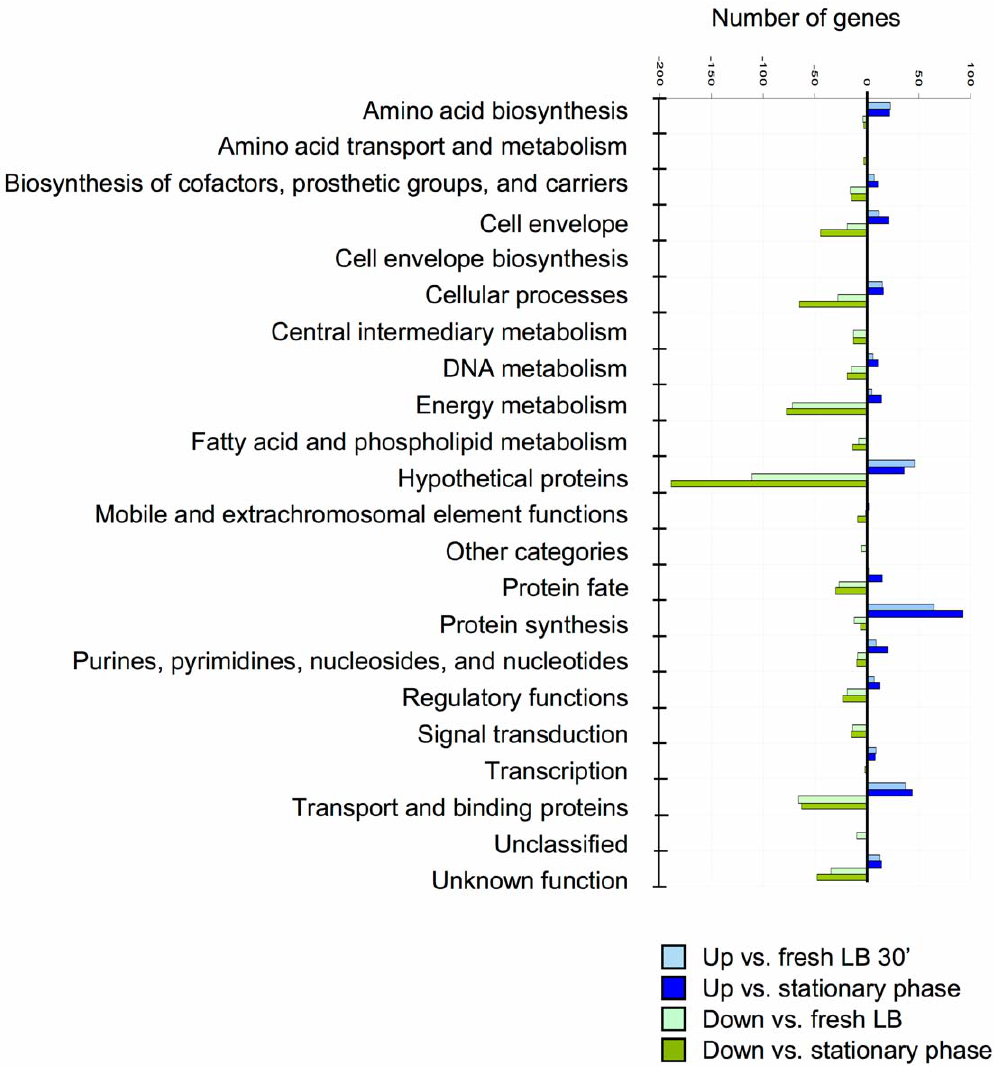
Figure 4. Alterations in transcription grouped according to CVI CMR main role categories. Genes with changes in transcription after 30 9 in vivo (compared to cells from stationary phase or growth in fresh LB) were categorized by their main role as assigned by the Craig J. Vintner Comprehensive Microbial Resource. A 2-fold or greater difference in transcription and significance p , 0.05 ANOVA was required for inclusion.